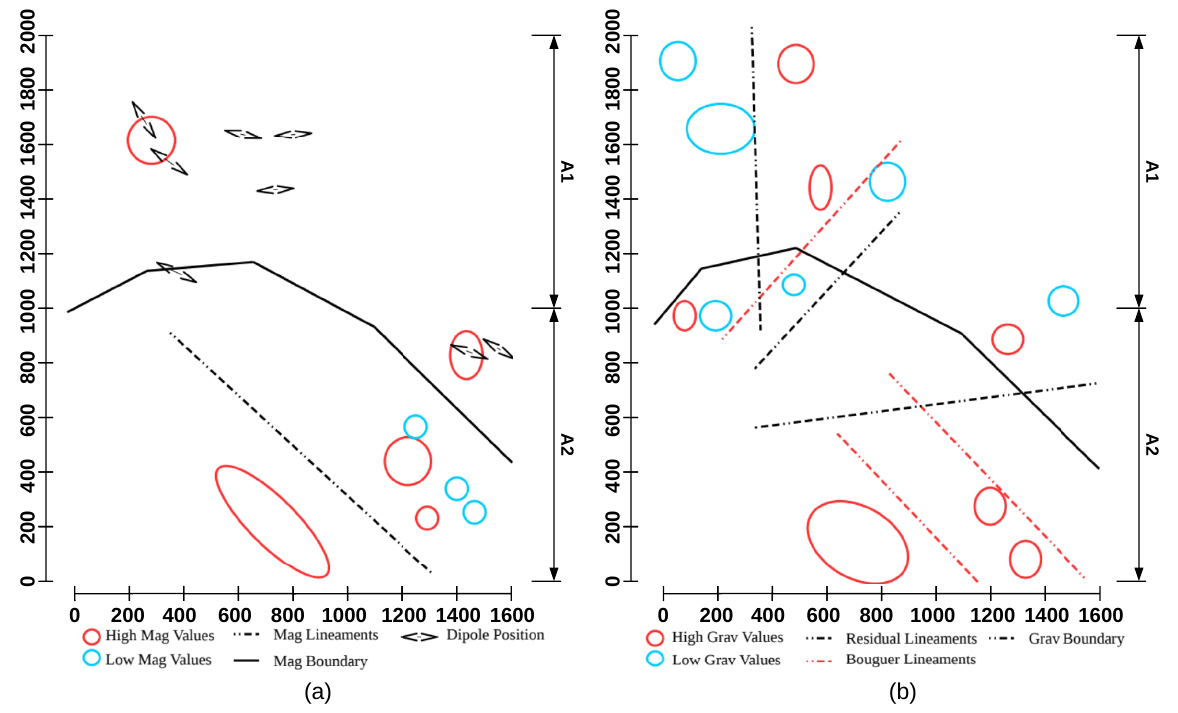
Figure 8. Display of the structural features of the area based on: (a) the magnetic and (b) the gravity